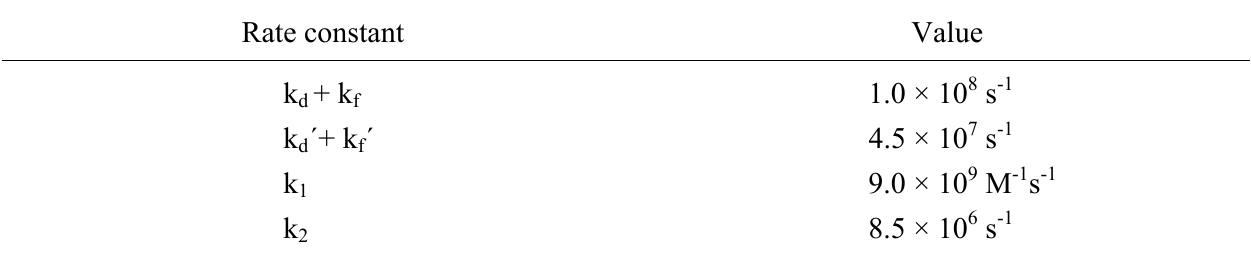
Table 3. Rate constants and pK* of CAZL derived from fluorescence decay